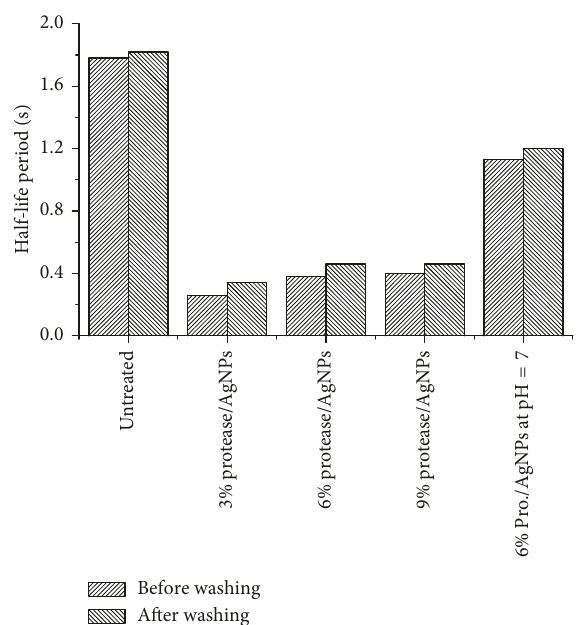
Figure 6: The half-life period of wool after